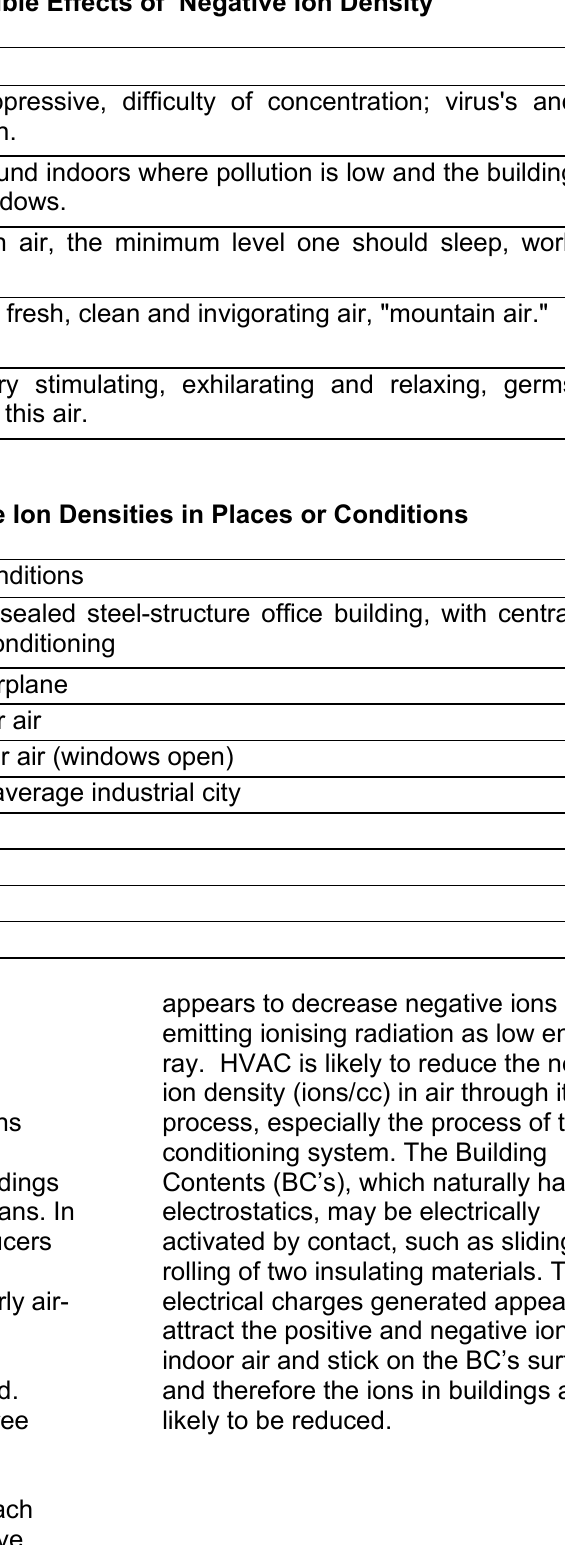
Table 1.1: Possible Effects of Negative Ion Density